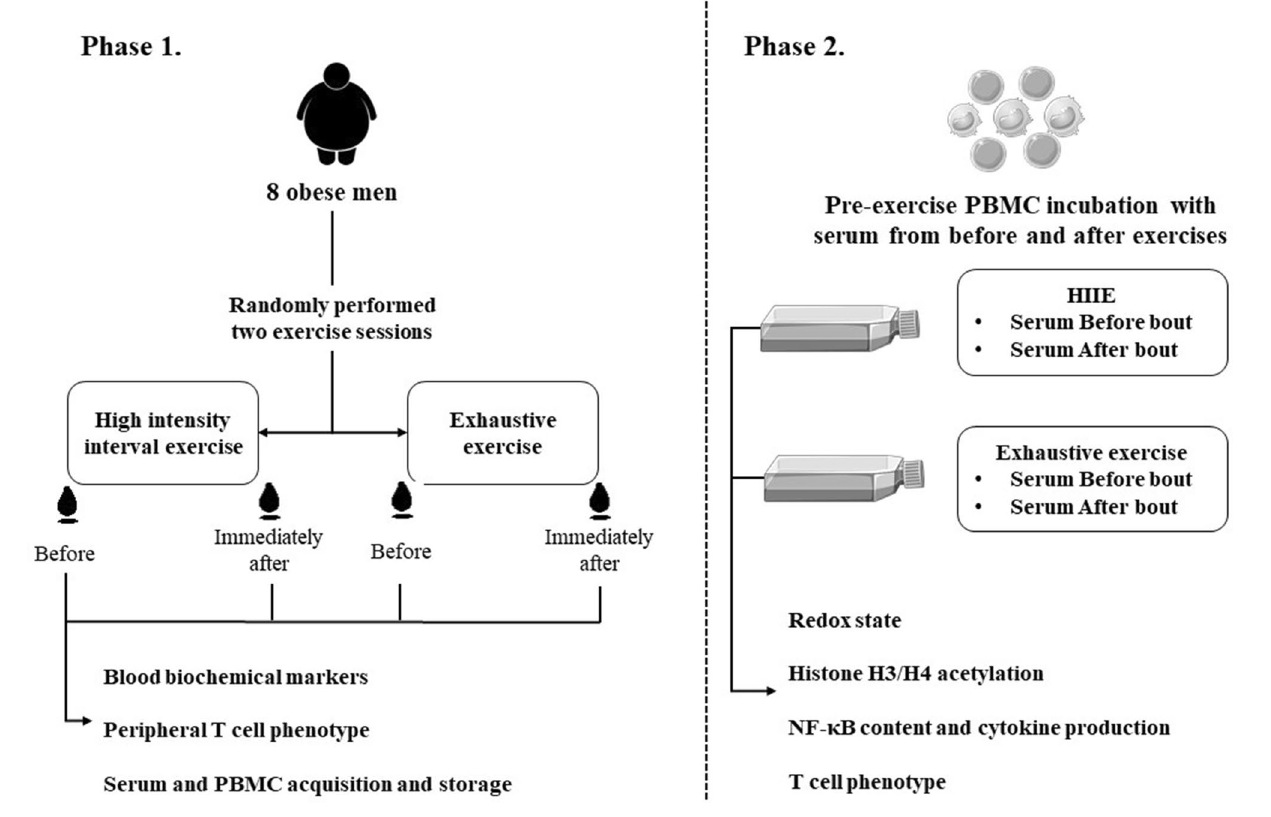
Figure 1. Study experimental